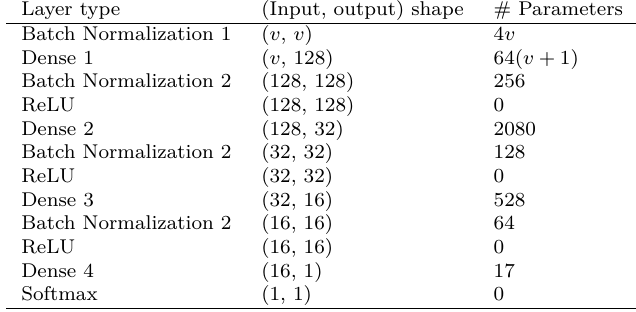
Table 2: The MLP architecture used in the message recovery attack. For N p 2 m and N a 2 a , the input size is v = 128. For the models using both points, v =